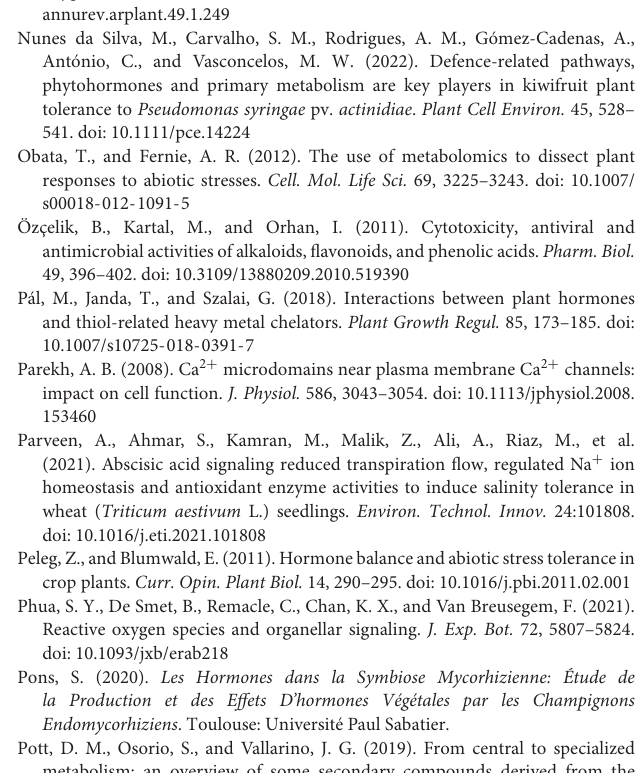
metabolism: an overview of some secondary compounds derived from the